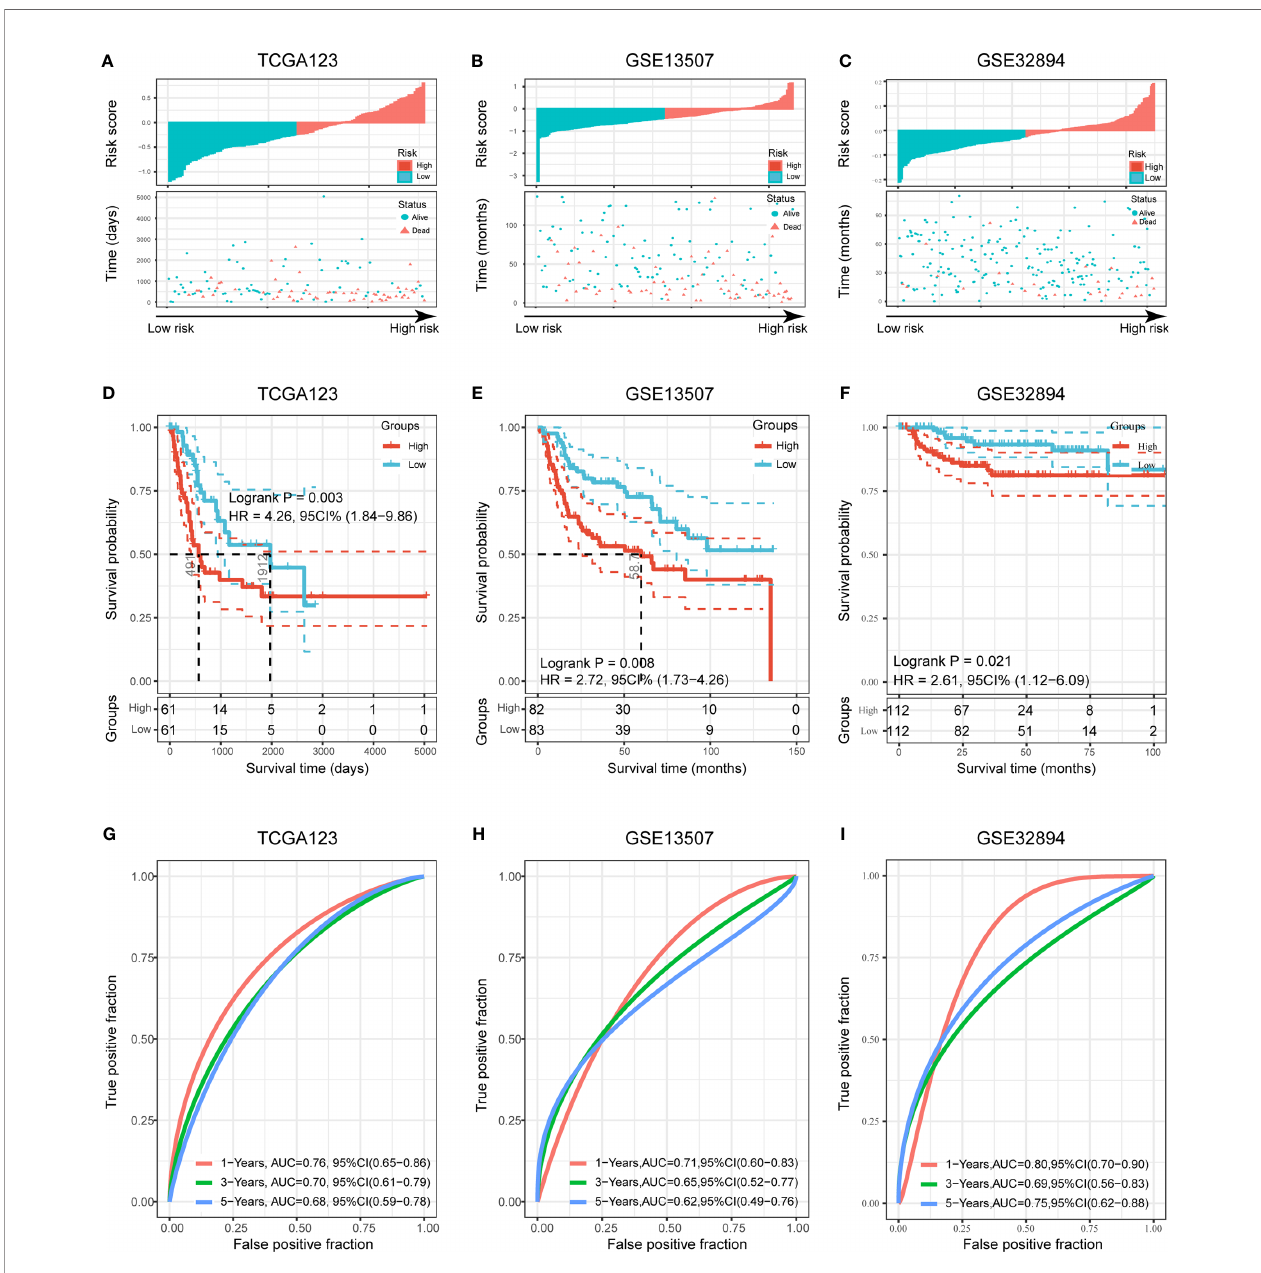
FIGURE 6 | Validation of the risk signature in three validation cohorts. (A – C) Risk score of each patient in the three data sets. (D – F) Kaplan-Meier analysis of patients in the high- and low-risk subgroups in the three data sets. (G – I) Time-dependent ROC analysis of risk score in predicting prognoses in the three data